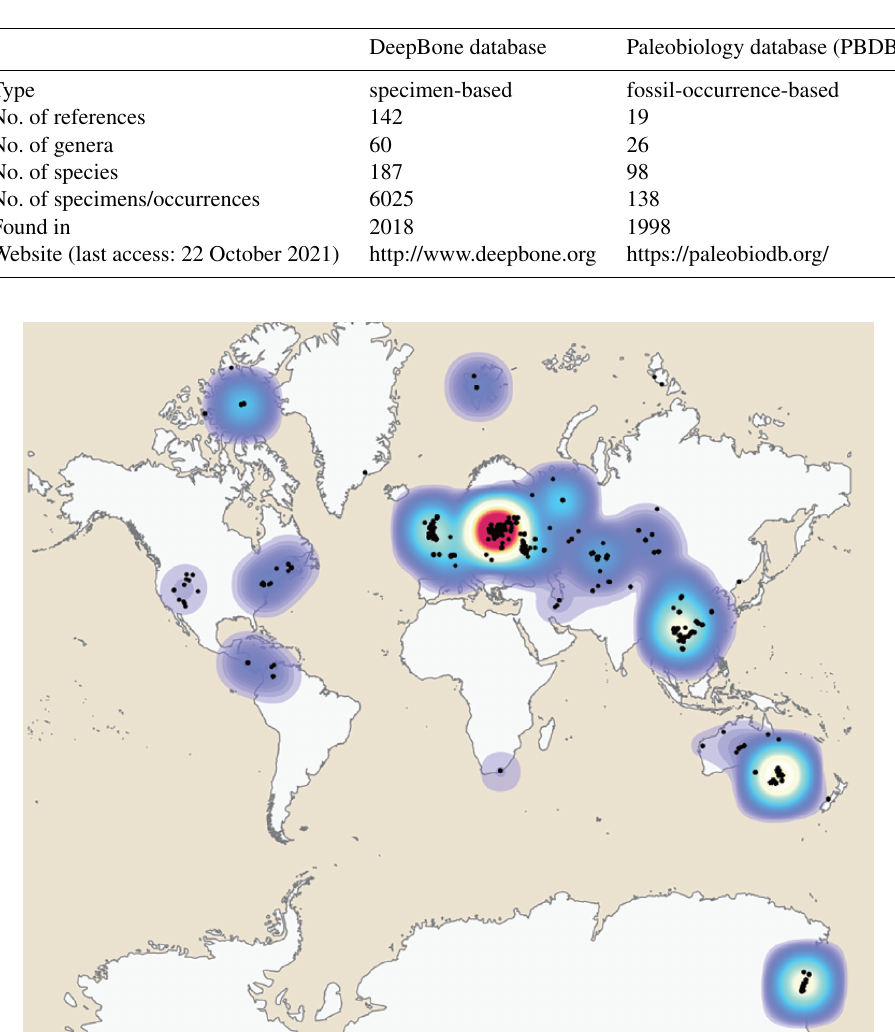
Table 2. Comparison of Antiarcha data in two paleontological databases.